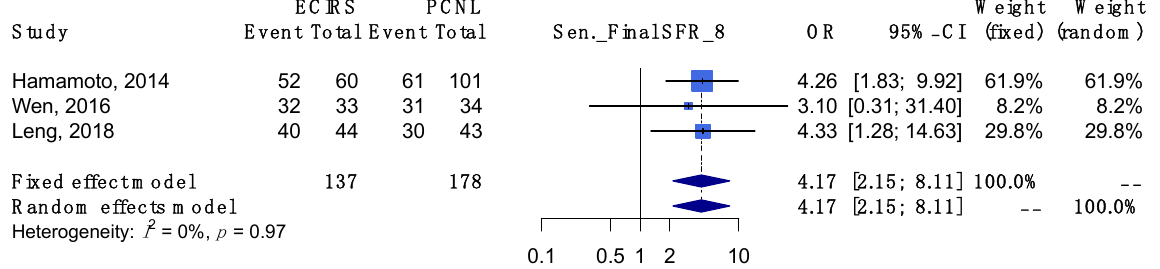
Figure A28. Sensitivity analysis of outcome regarding initial stone free rate. ([17–19,22])